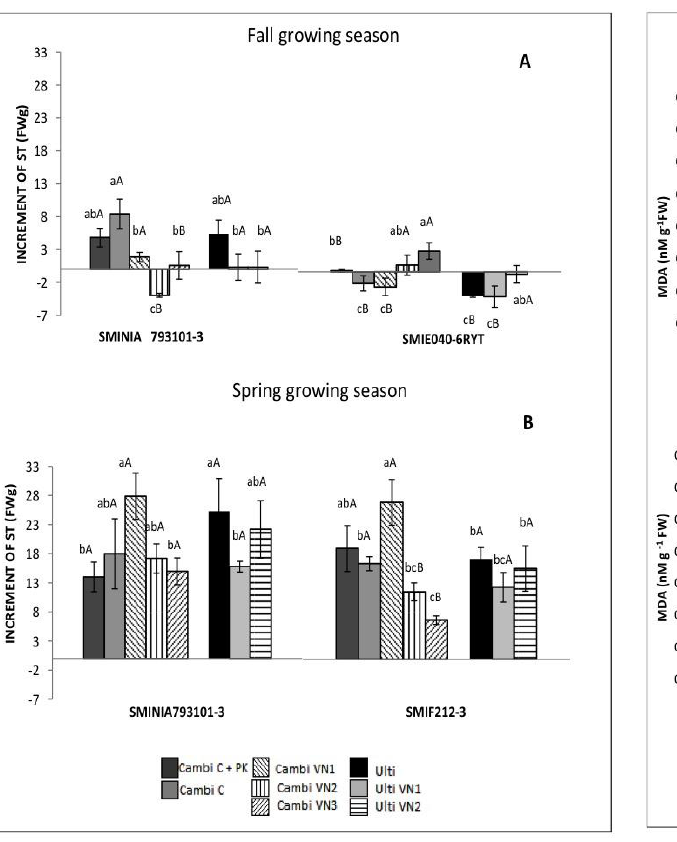
Fig. 4: Effect of increasing Cu levels on leave lipid peroxidation in different development stages (tuber initiation and 15/18 days before harvesting) of different potato genotypes at fall (A) and spring (B) growing seasons. Data represent the mean ± S.D. of six replicates. Different lowercase letters indicate significant differences between Cu levels in the same potato genotype (p < 0.05). Different capital letters indicate significant differences between potato genotypes at the same Cu level (p <